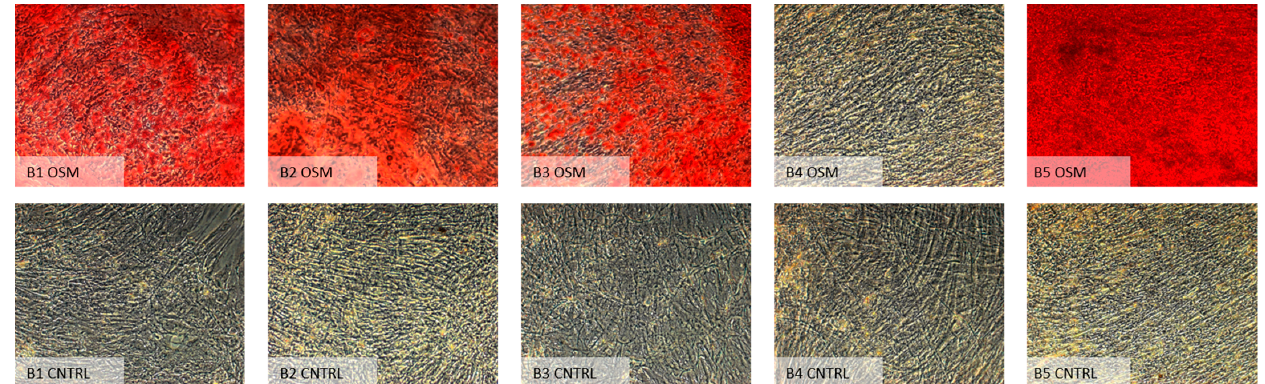
Figure 7. Microscopic images (10×) of all groups from one donor expanded in α -MEM (condition B), followed by differentiation in specific media according to the individual group (1–5). OSM = osteo- genic media, CNTRL = negative control group.